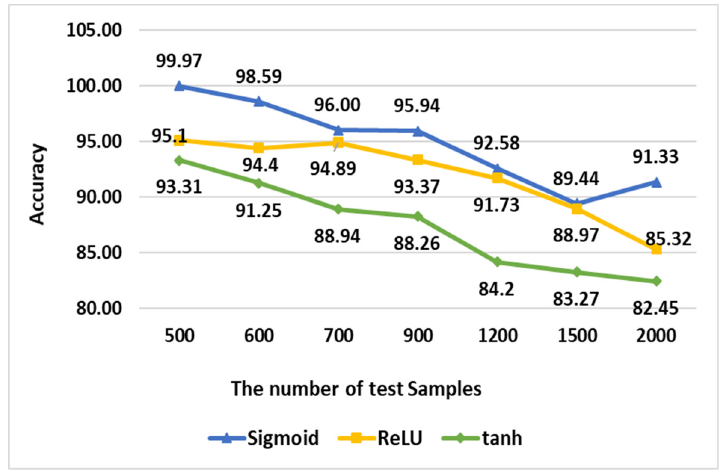
Figure 17. The data accuracy of an activation function.